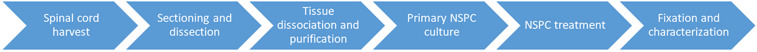
Experimental work-flow depicting spinal cord extraction (20–40 min), central canal dissection (20–40 min), tissue dissociation and purification (2–3 h), NSPC culture (up to 10 weeks), treatment (up to 3 weeks), and characterization (2 days).